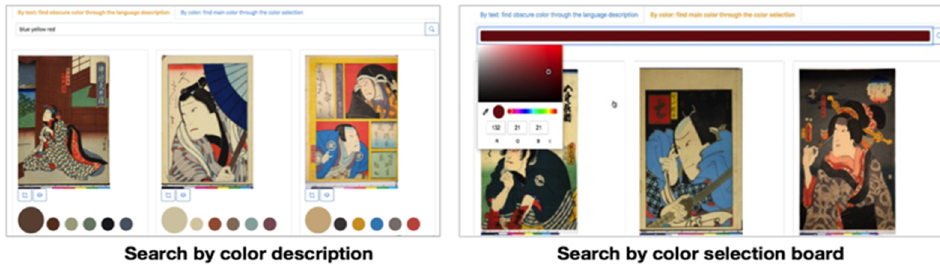
Figure 19. Demo application implementation.